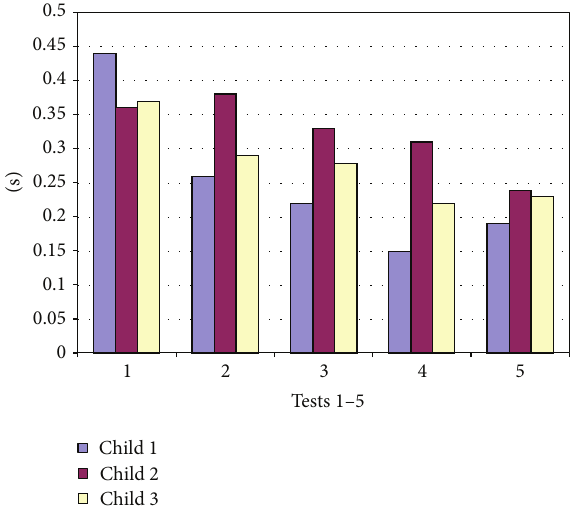
Figure 2: Deviation from the optimal inspiration moment in seconds in test 1 before training and in tests 2 to 5 after training in collective 1 and 2.